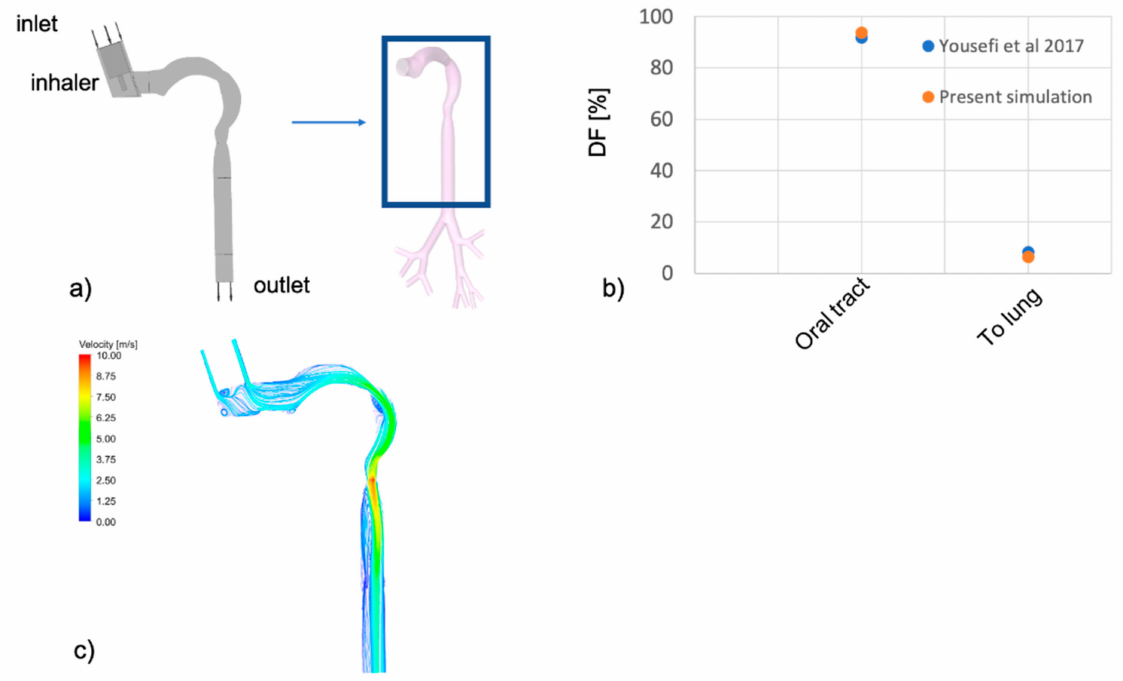
Figure A2. Computational human model with human upper airway tract and pMDI used for validation ( a ) and regional deposition fractions (DF; in %) computed and displayed in comparison with the literature data (Yousefi et al., 2017) for inspiratory flows Q of 30 L/min ( b ). In ( c ), the velocity distribution inside the oral airways is represented by means of velocity